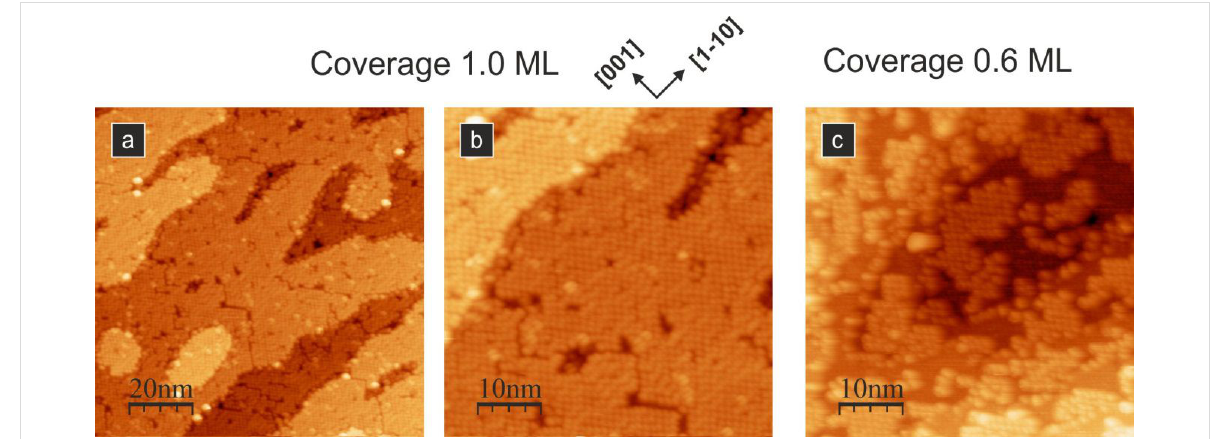
Figure 6: Empty-state STM images of the densely packed molecular structures. (a) and (b): closed layer PTCDA structure obtained when the mole- cules are adsorbed on the sample kept at elevated to 100 °C temperature; (c) 0.6 ML of PTCDA molecules adsorbed on the sample kept at 100 °C. All STM images acquired with 2 pA tunnelling current and 2.0 V bias voltage.